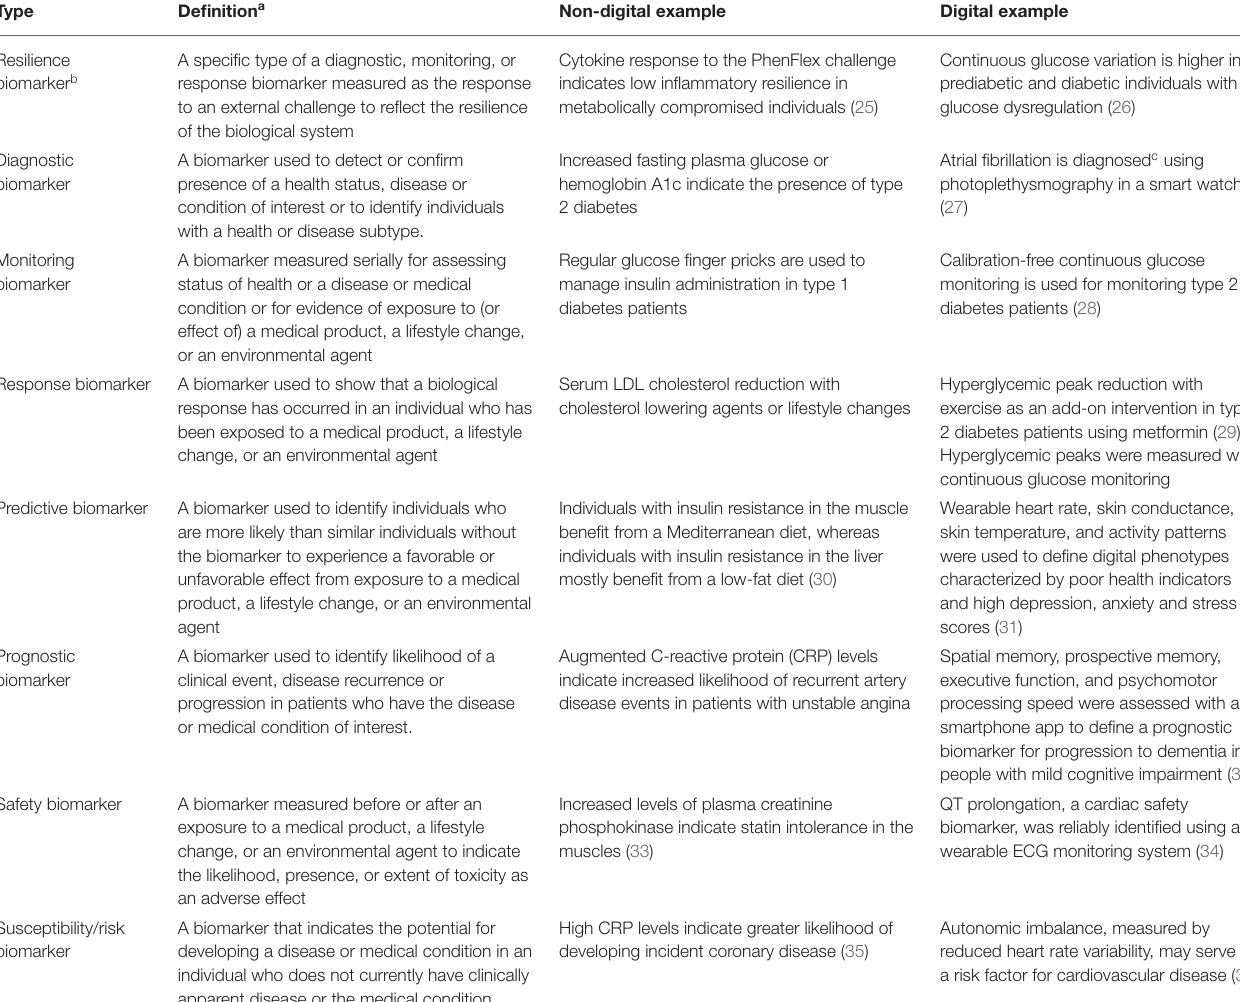
TABLE 1 | Definitions, non-digital, and digital examples for eight biomarker